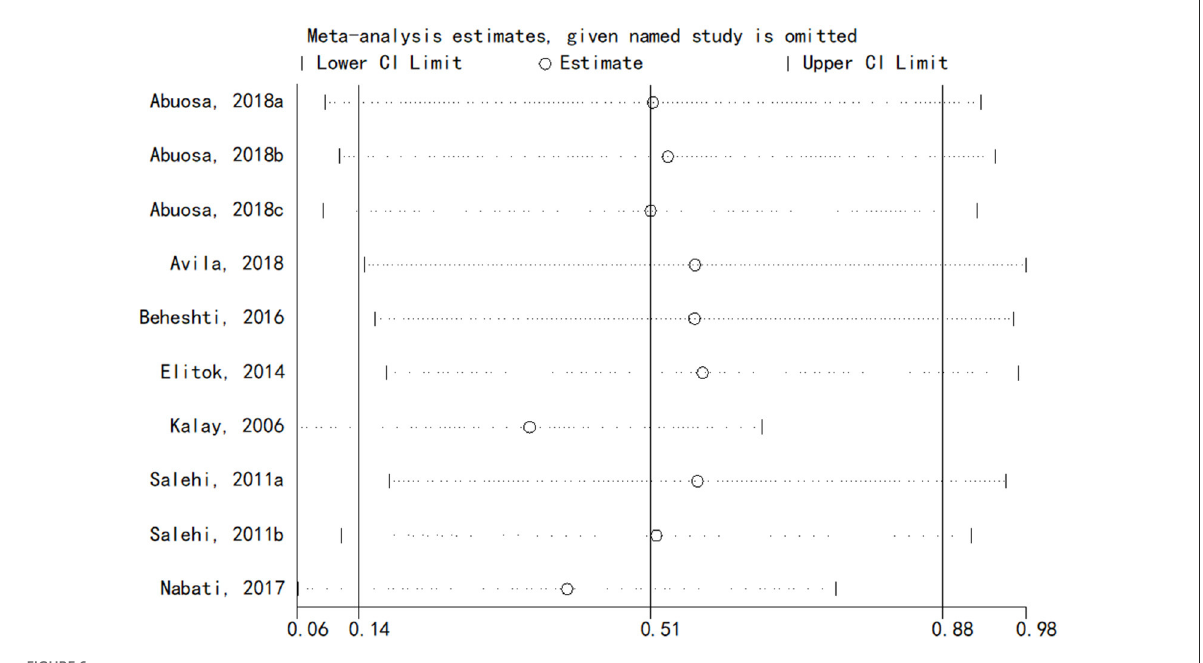
FIGURE6 Sensitivity analysis results.